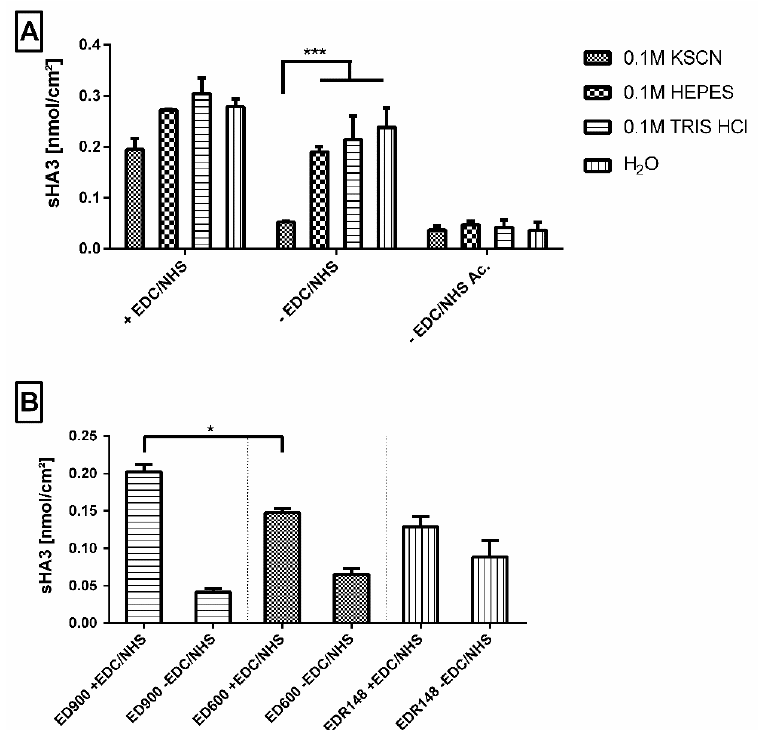
Figure 4. ( A ) Effect of different washing buffers on the amount of fluorescence labeled sHA3 detected on ED900 modified film surfaces. Sulfated hyaluronan was introduced with (+EDC/NHS) and without (-EDC/NHS) the addition of EDC/NHS reagent mix to ED900 modified surfaces and to ED900 acetylated (-EDC/NHS Ac.) control groups. ( B ) Effect of different linkers on the amount of fluorescence labeled sHA3 detected on modified film surfaces. Sulfated hyaluronan was introduced with (+ EDC/NHS) and without (-EDC/NHS) the addition of EDC/NHS reagent to polyetheramine EDR148, ED600, and ED900 modified surfaces. All values represent the mean ± SD of n ≥ 4. * p < 0.05, *** p < 0.001 denotes significant difference vs. the respective surface modification.